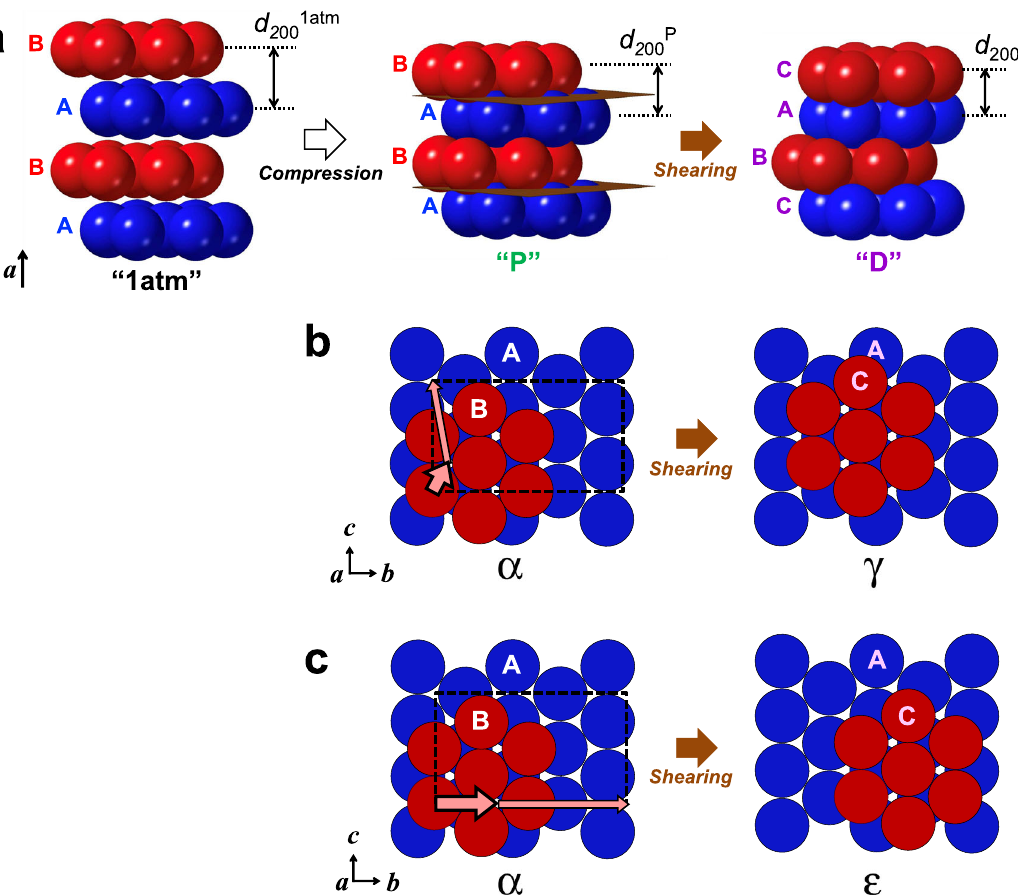
Fig. 4 Schematic illustrations of shearing mechanism of Mg 2 SiO 4 . a Perspective views of oxygen anion layers, showing how the original α structure (1 atm) was compressed along its a -axis (P), and then recrystallised into the dense structure (D) induced by fast shearing (slipping) motions of these layers at the slip planes shown with brown colour. The original α structure consists of alternating A and B layers of oxygen forming a hexagonal close packing (hcp) arrangement. The dense polymorph structure ( β , γ , or ε ) all consists of alternating A, B, and C layers of oxygen forming a cubic close packing (ccp) arrangement. b The shearing model toward the γ structure, where cooperative slip motions of the oxygen layers occur along the c axis of the α structure, [001] α . Only the oxygen anions are shown for clarity. See Supplementary Fig. 4 for the accompanying cooperative motions of magnesium and silicon cations. The unit cell of α structure is indicated by the rectangle with dotted lines. The upper layer B slips with respect to the lower layer A by partial dislocation with Burgers vector b p = 1/12[013] α , as indicated by the thick solid pink arrow. The other partial dislocations were indicated by the thin solid pink arrow, where all these partial dislocations in total constitute the perfect dislocation with the Burgers vector b t = [001] α that de fi nes the direction of macroscopic shearing along the c axis 17,26 . c The shearing model toward the ε structure, where cooperative slip motions of the oxygen layers occur along the b axis of the α structure, [010] α . The unit cell of α structure is shown by the rectangle with dotted lines. The layer B slips with respect to the layer A by partial dislocation with b p = 1/3[010] α , as indicated by the thick solid pink arrow. The other partial dislocations were indicated by the thin solid pink arrow, where all these partial dislocations in total constitute the perfect dislocation with b t = [010] α that de fi nes the direction of macroscopic shearing along the b axis 17